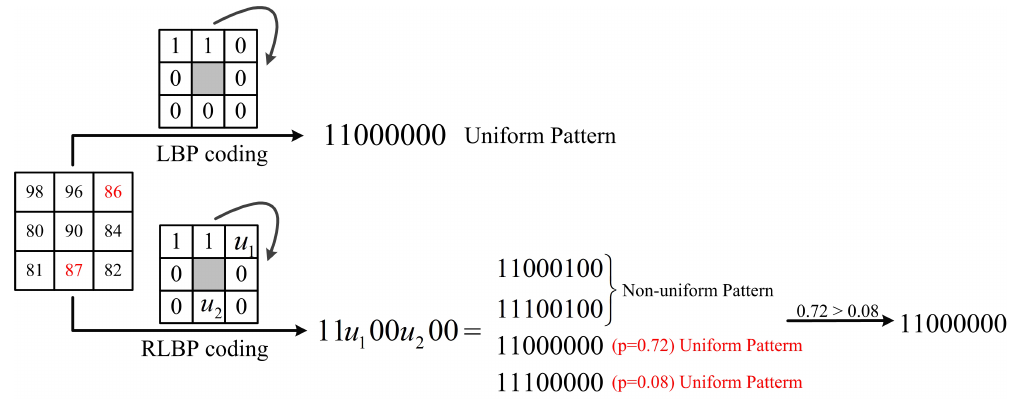
Figure 6. The comparison of LBP and RLBP patterns in a 3 × 3 sliding window with more than one patterns in uncertain RLBP pattern collection belong to the uniform patterns.